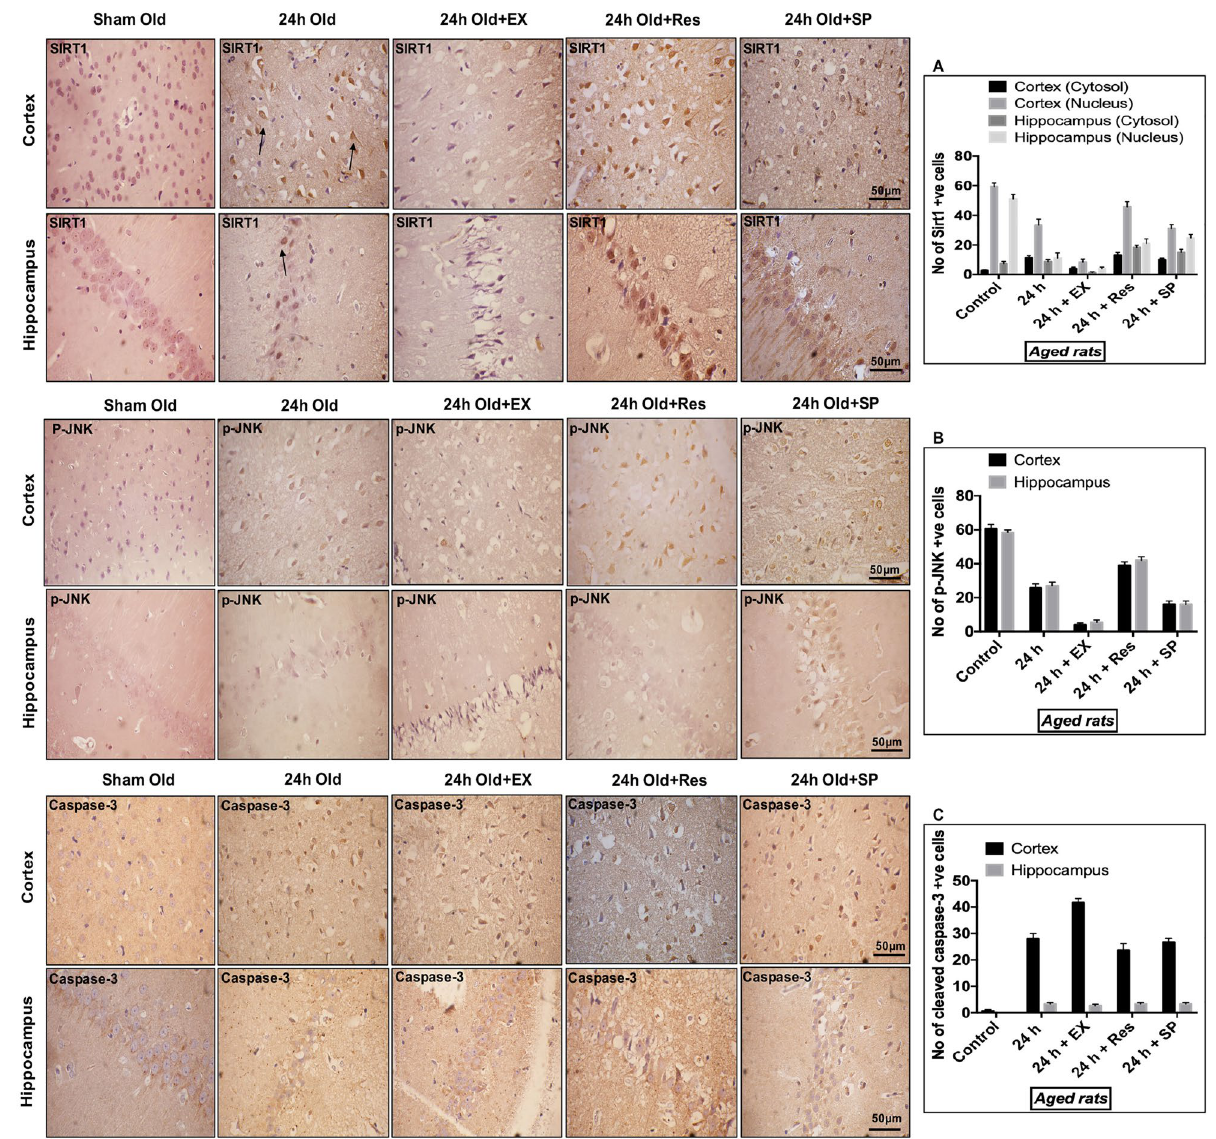
Figure 3. Subcellular localization of SIRT1, p-JNK, & caspase-3 in aged rats following CI. Aged rat brains were paraffin embedded and sectioned into 5–10 μm thick slices (n = 4). (A) Subcellular distribution of SIRT1 in the brains of aged rat cortex and hippocampus neurons from sham control as well as brains from 24 h after MCAO, MCAO + EX-527, MCAO + resveratrol, and MCAO + SP600125 treatment. (B) p-JNK immunoreactivity in the brains of aged rat cortex and hippocampus neurons from control as well as brains from 24 h after MCAO, MCAO + EX-527, MCAO + resveratrol, and MCAO + SP600125 treatment. (C) Nuclear immunoreactivity of activated caspase-3 in the brains of aged rat cortex and hippocampus neurons from control as well as brains from 24 h after MCAO, MCAO + EX-527, MCAO + resveratrol, and MCAO + SP600125 treatment (magnification 400X; Scale Bar—50 μm). Immunoreactivity for SIRT1, p-JNK, and caspase-3 was depicted in brown (DAB). The neuronal nucleus is visualized with Hematoxylin